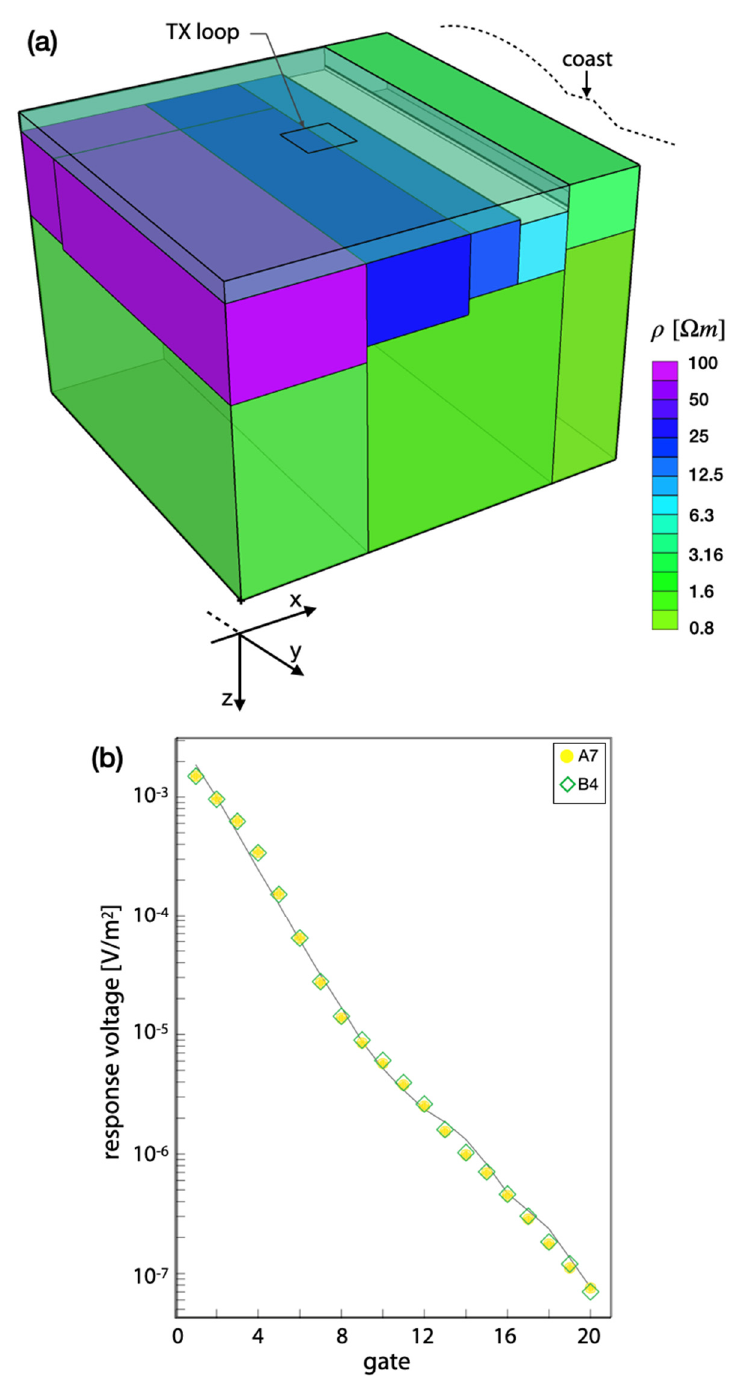
Figure 12. ( a ) 3D resistivity model showing the subsurface geoelectrical distribution beneath A7 and B4; ( b ) The computed step ‐ off voltage according to the resistivity model in (a) is displayed as a black line.